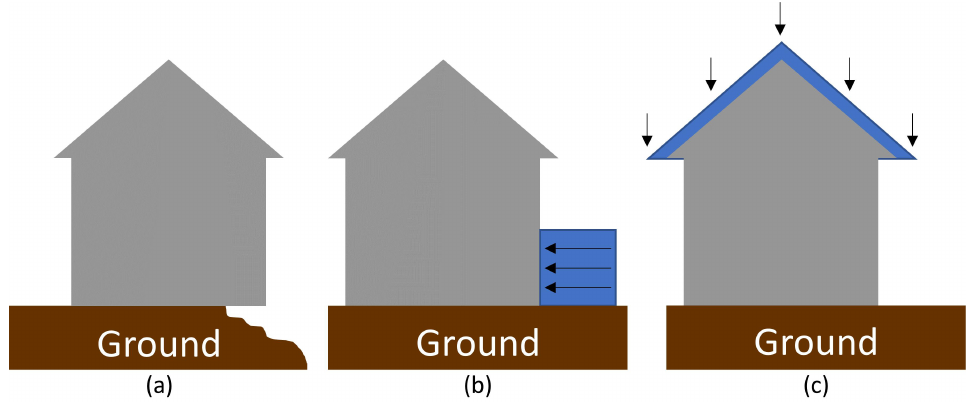
Figure 10. Buildings at Dzaleka Refugee Camp can collapse from water-related events in three different ways: ( a ) foundation undermining, ( b ) hydraulic pressure damage, and ( c ) roof collapse from water